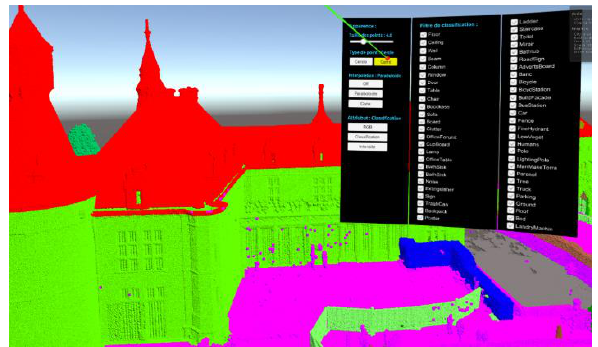
Figure 9. The scene as seen in the headset by the user.